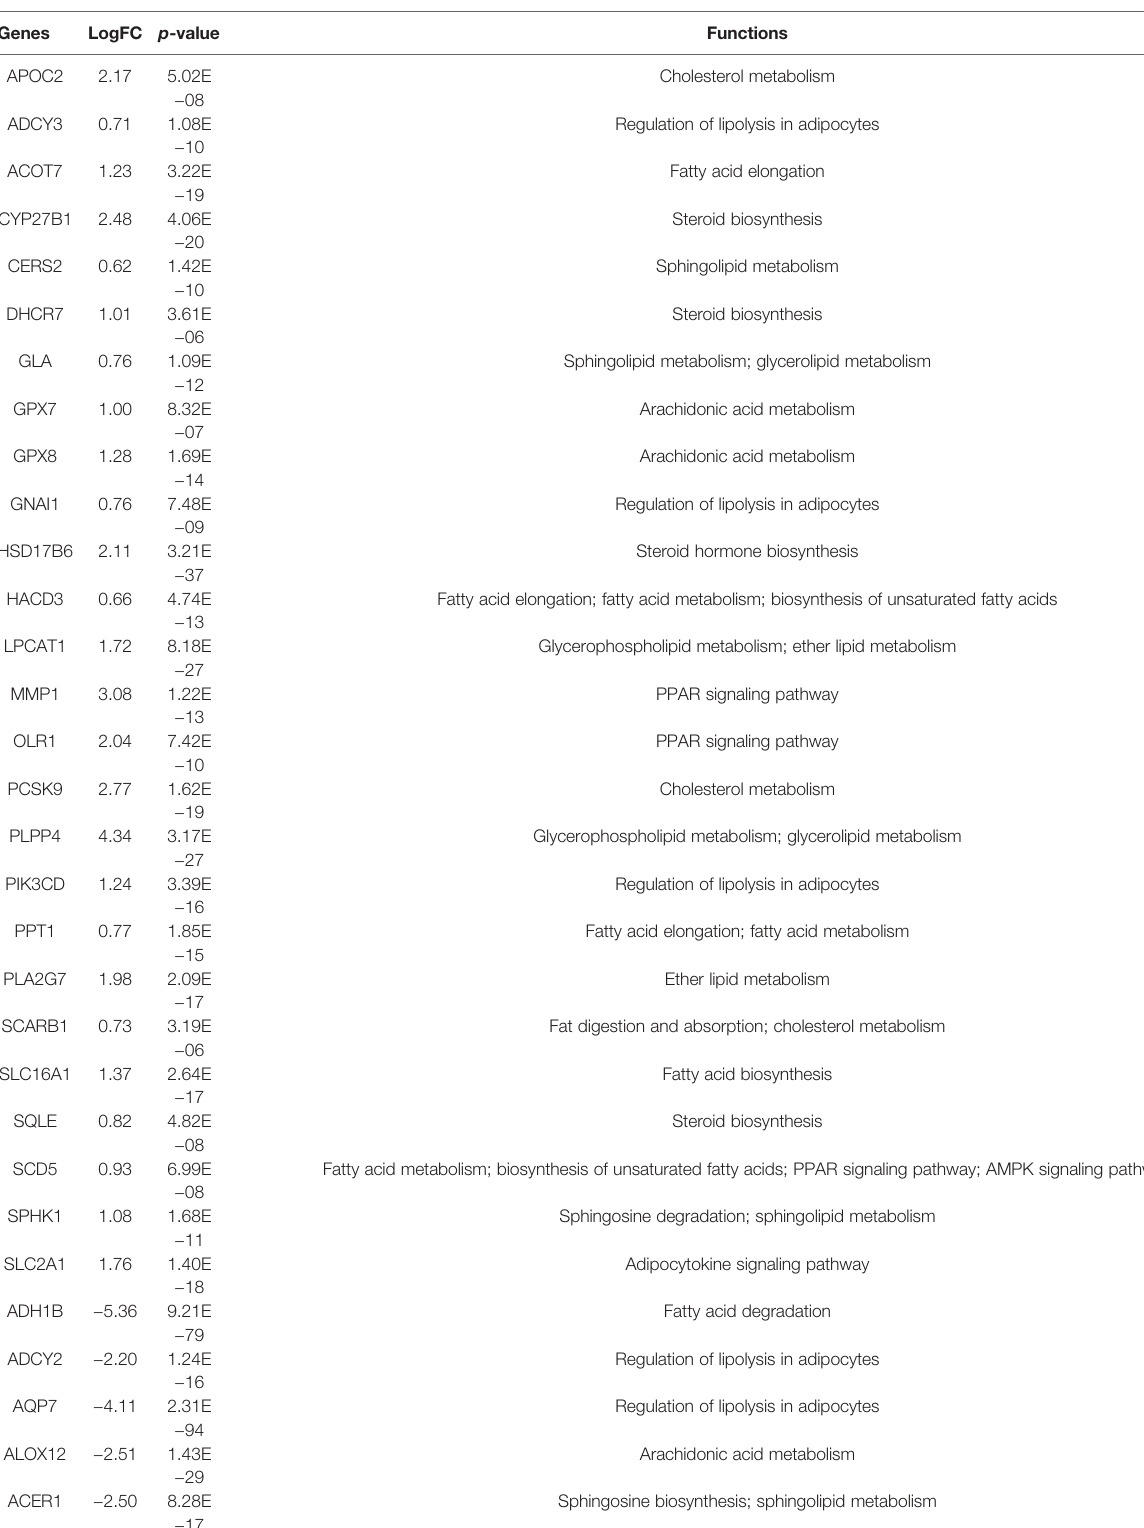
TABLE 1 | The lipid-related DEGs among GSE30784, GSE37991, and